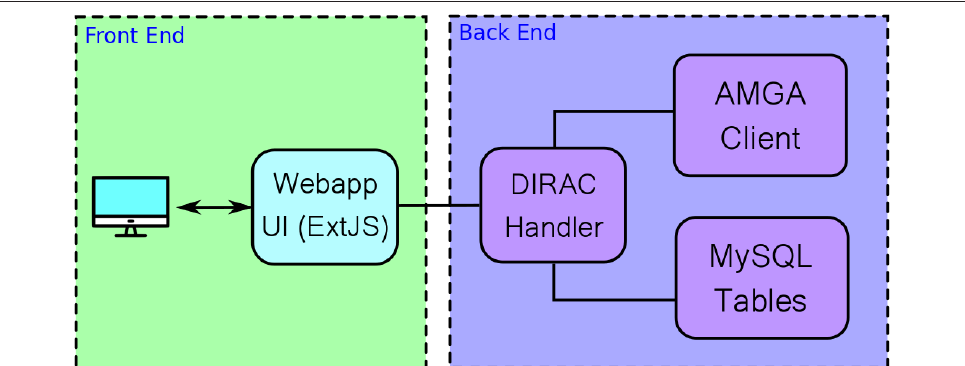
Figure 3: End users interact with a GUI written in extended JavaScript which is responsible for passing the search criteria onto the Dirac handler written in Python. The handler then communicates with the AMGA client and MySQL tables before returning the results back to the ExtJS